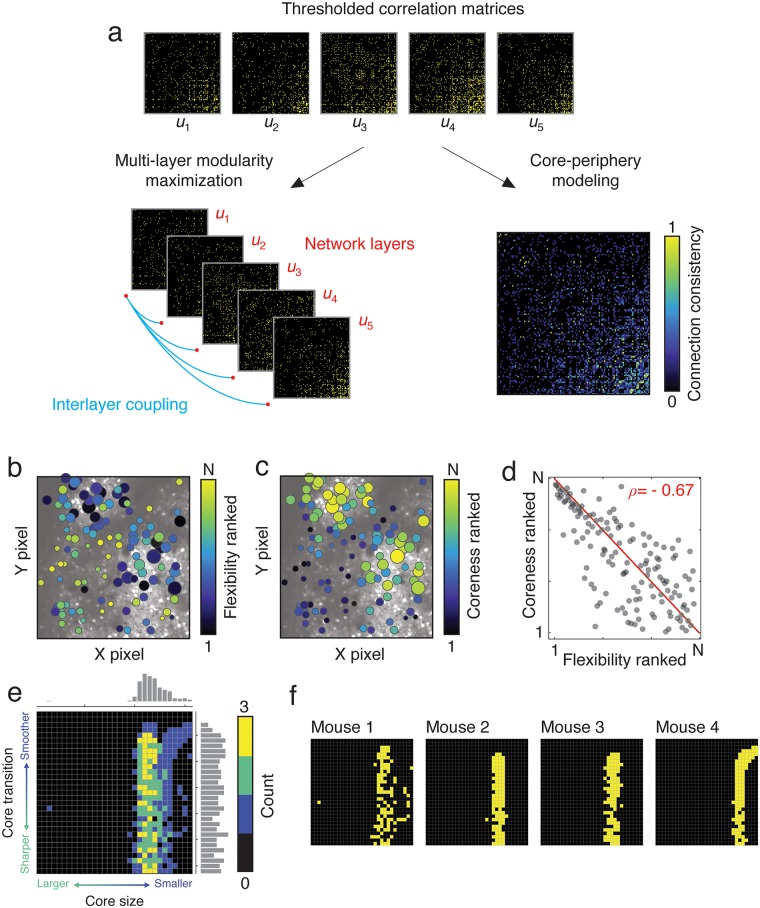
Estimation of core-periphery structure and network flexibility.(a) Thresholded correlation matrices are separately treated as: a) layers in a multi-layer network, their communities estimated, and network flexibility estimated as the frequency with which a node changes its community assignment across layers; b) the consistency matrix is submitted to a core-periphery detection algorithm and each node’s “coreness” is estimated. Here, consistency measures the fraction of layers (recording sessions) in which a connection was present. (b) Node’s flexibility scores plotted in anatomical space. (c) Nodes’ “coreness” plotted in anatomical space. The size of nodes in panels b and c is proportional to their average weight across all five recording sessions. (d) Because flexibility is a measure of variability while “coreness” is a measure of stability, we find that the two are inversely correlated with one another (red line represents the identity line). (e) Cross-subject consistency of optimal parameters for fitting the core-periphery model. For each mouse, we calculated the difference between observed core quality and that of a null model, and we retained the top 10% of those points. These points are depicted at the level of individual mice in panel f. In panel e, we aggregate those values across all mice.